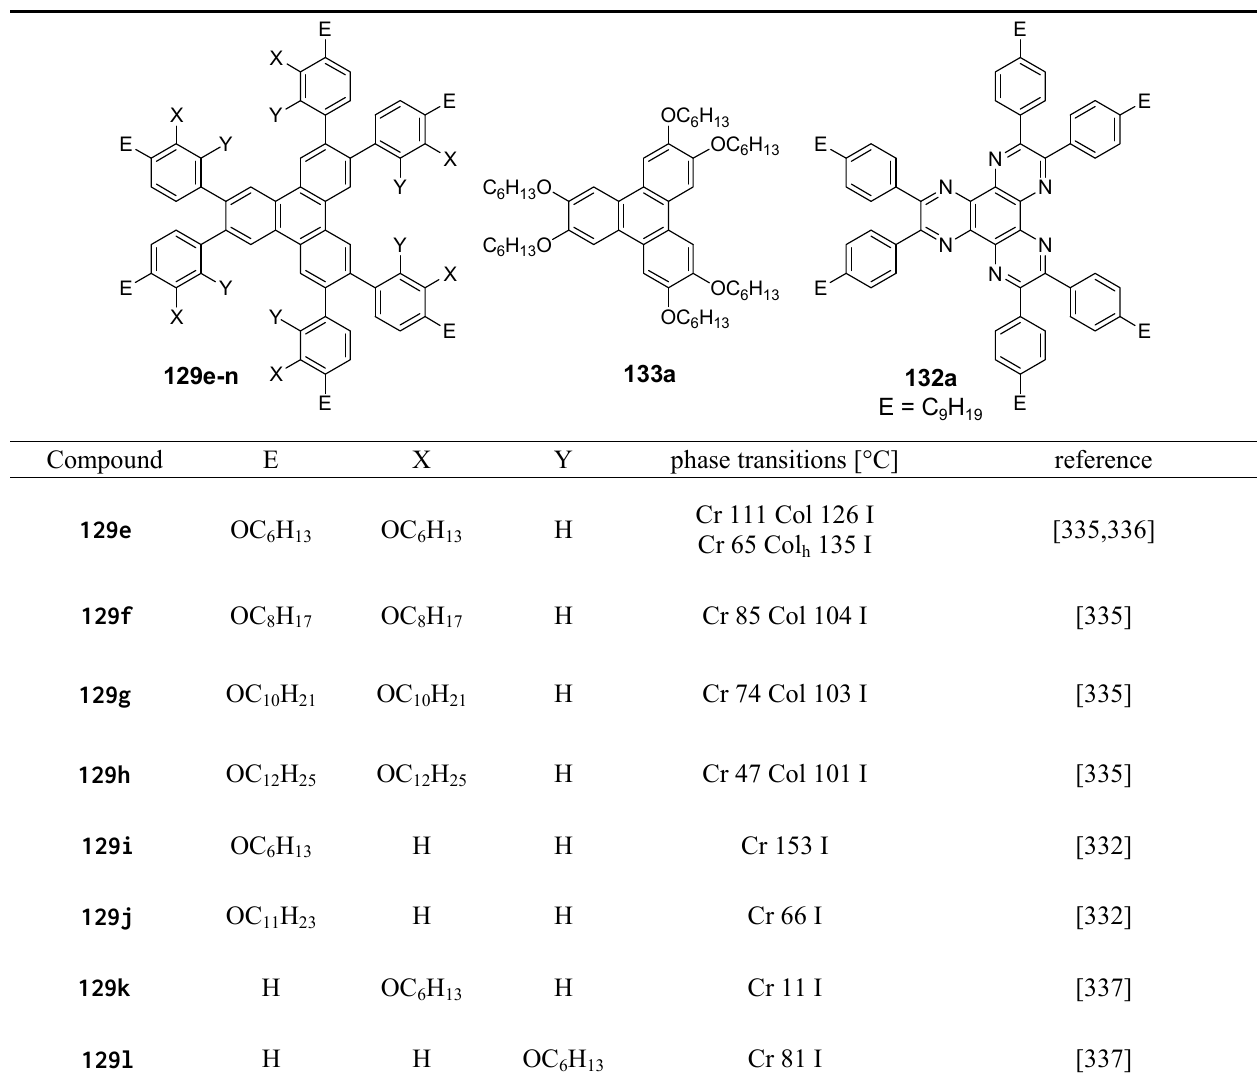
Table 9. Mesomorphic properties of triphenylenes 129